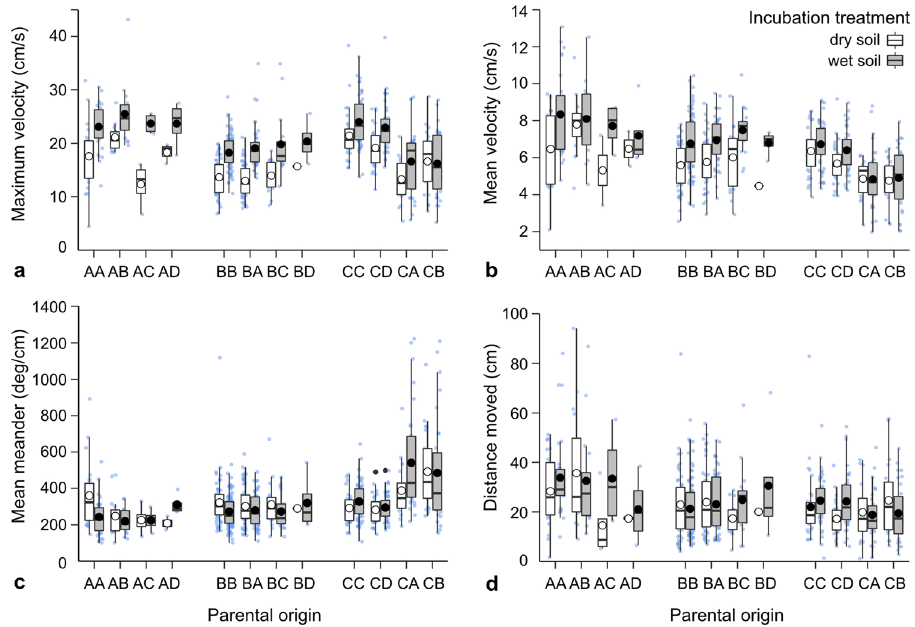
Fig. 3 Swimming performance traits (a – d) of hatchlings reared at two soil treatments (dry and wet) in within- and between-population crosses of four populations. Traits were measured for 633 tadpoles (Supplementary Table 2). The fi rst letter of the parental origin represents the female (population) origin, and the second letter represents the male origin. Mean responses (large white or black circles, according to treatment) are superimposed over boxplots, which are superimposed over raw data (jittered small blue circles). Lower and upper boxplot boundaries are 25th and 75th percentiles, respectively, the thicker line inside the box is the median value, and lower and upper error bars are 10th and 90th percentiles,